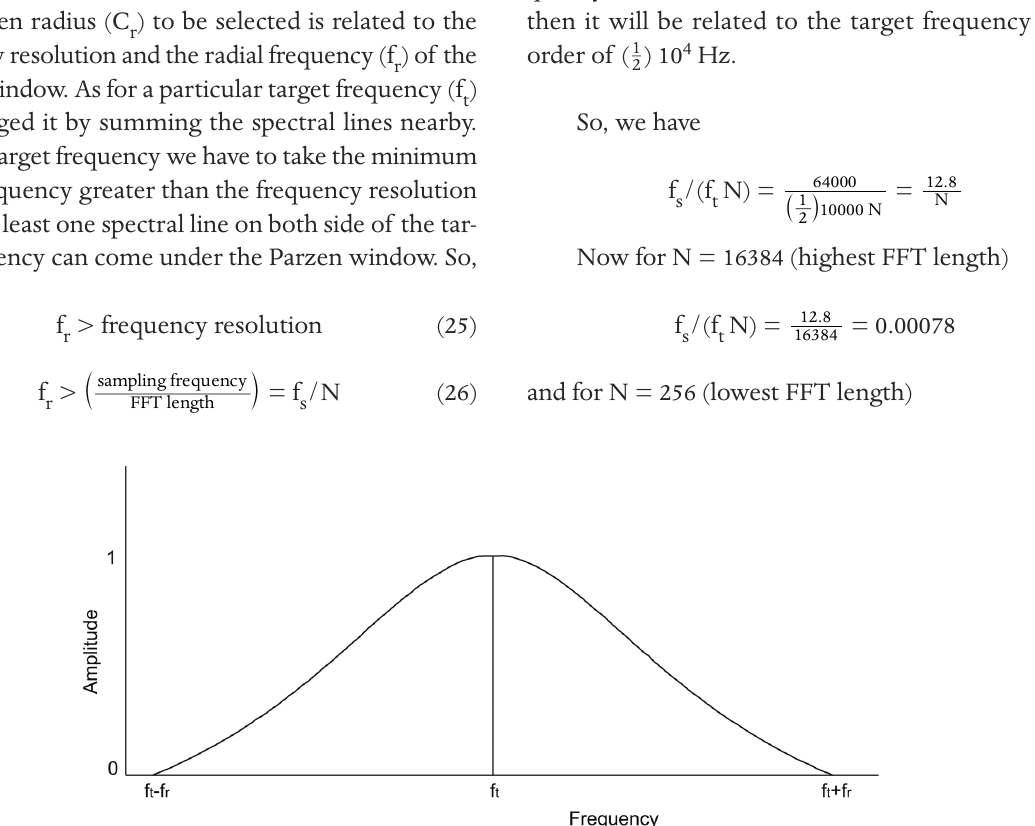
’ in frequency domain. f t